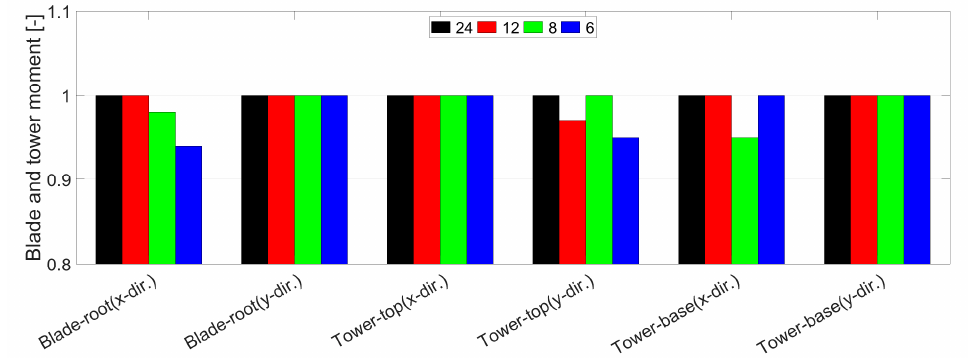
Figure 17. Normalized values for maximum platform’s motion according to the interval angles.